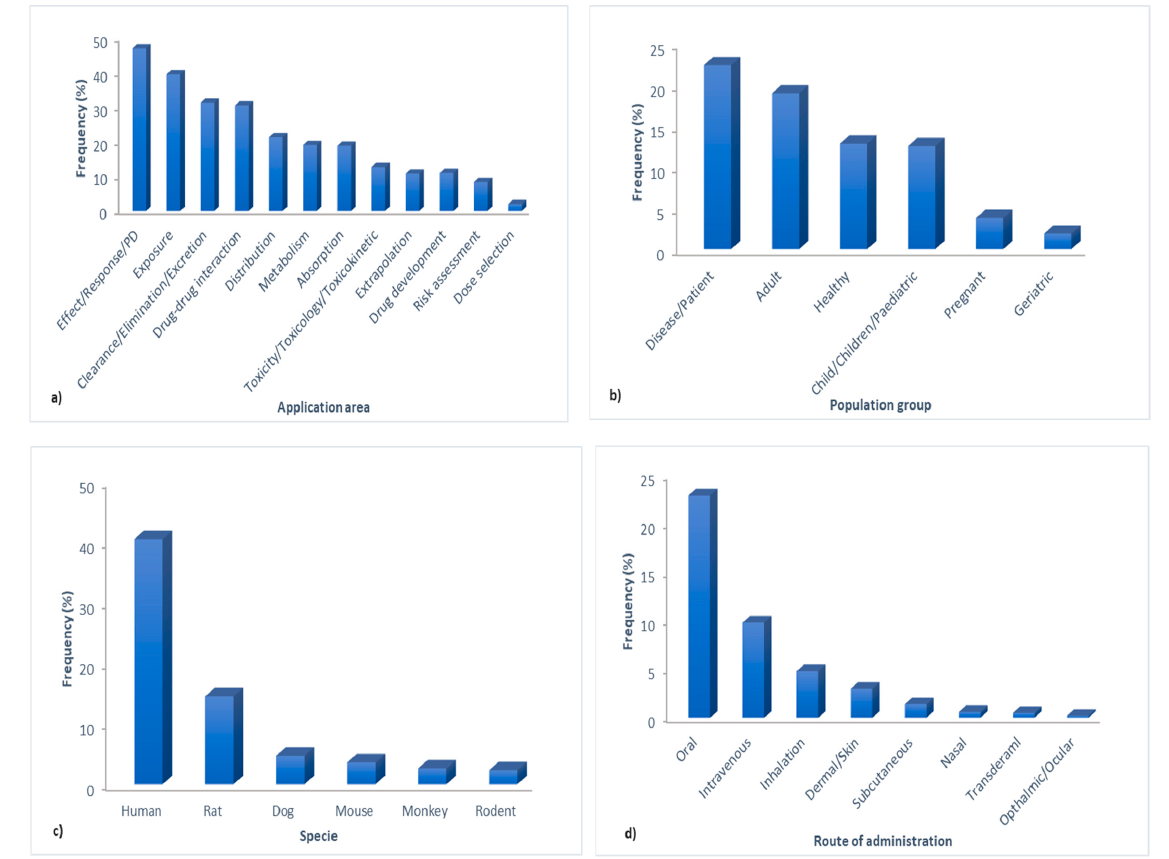
Figure 5. Distribution of PBPK modeling application: ( a ) across the analyzed publications; ( b ) for different population groups; ( c ) for different species; ( d ) for different administration routes.